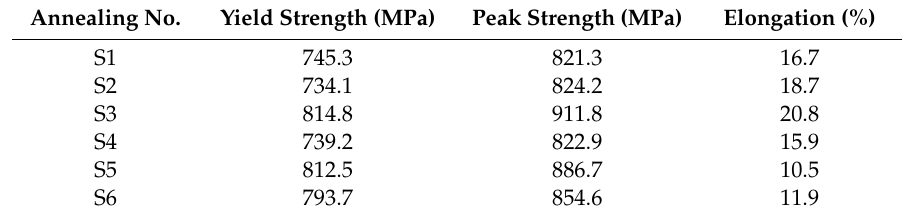
Table 3. The room temperature mechanical properties of TA17 with di ff erent microstructures. Annealing No.